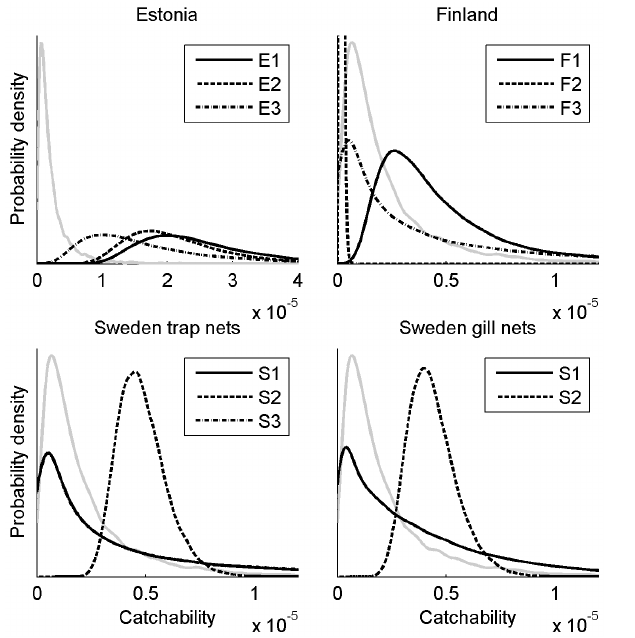
Figure 3. The posterior (black lines) and the marginal prior (grey line) distributions of catchabilities C g , a